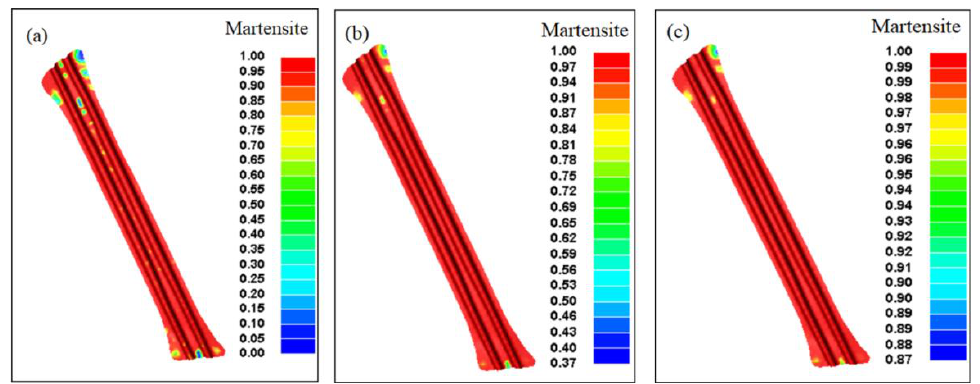
Figure 7. Martensite content of the formed part at the end of the holding pressure and quenching; ( a ) process 1, ( b ) process 2, and ( c ) process process 1, ( b ) process 2, and ( c ) process 3.